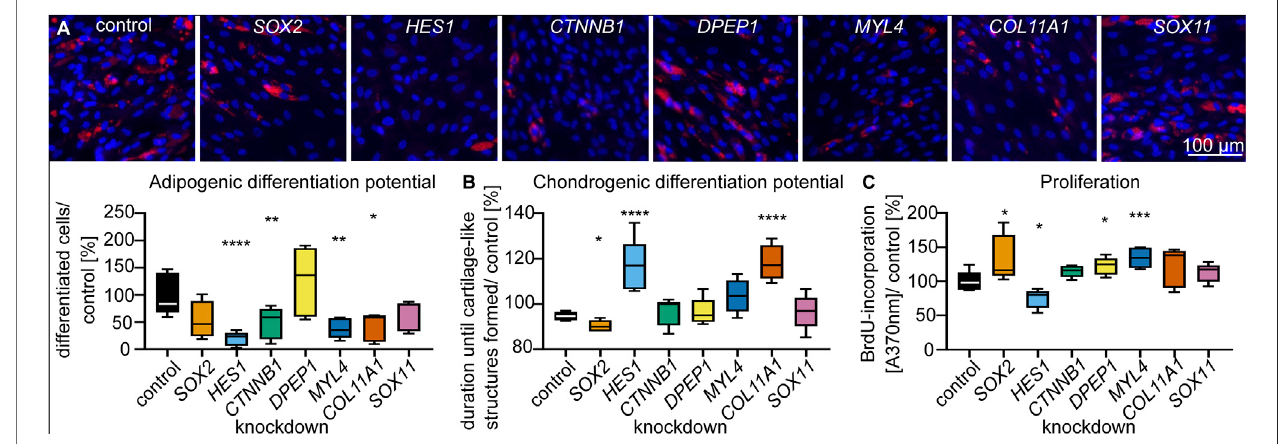
FIGURE 5 | Characteristic genes of the dermal sheath regulate stem cell characteristics. (A) Adipogenic differentiation potential, (B) chondrogenic differentiation potential and (C) proliferation, 72 h after knockdown of DS genes. n (cid:1) 5, * p < 0.05, ** p < 0.01, *** p < 0.001, **** p < 0.0001 (RM one-way ANOVA with Dunnett multiple testing